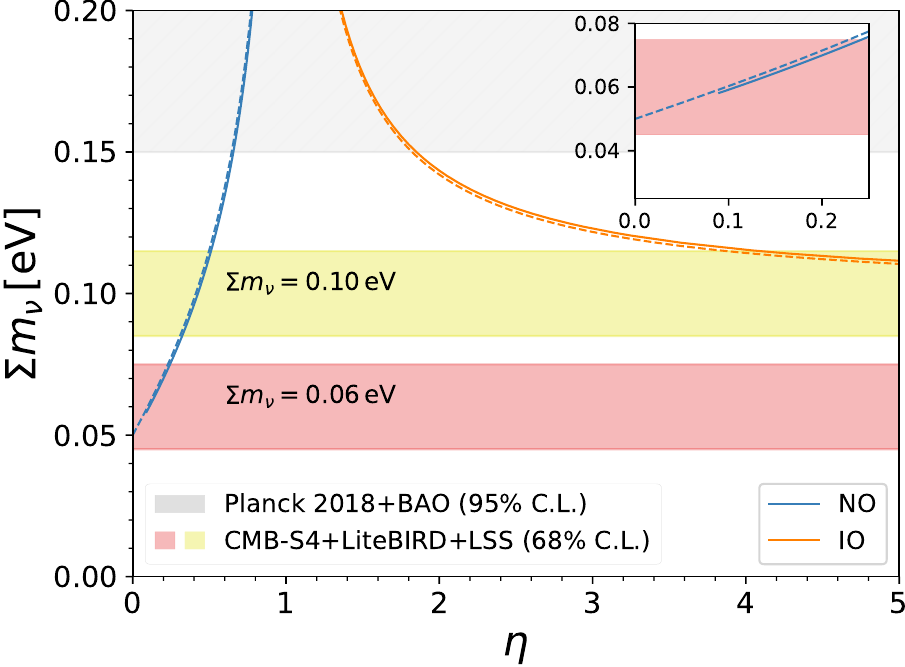
Figure 2 . Bounds from existing and upcoming cosmological observations on the sum of the neutrino masses P m (cid:23) as a function of the parameter (cid:17) for the \simplest mass matrix" (eq. (3.5), dashed curves) and \full mass matrix" (eq. (3.13), solid curves), given the constraints from oscillation experiments, for NO (blue curves) and IO (orange and green curves). The color code matches the one used in (cid:12)gure 1. For the simplest mass matrix, there are two curves, one for each ordering. In